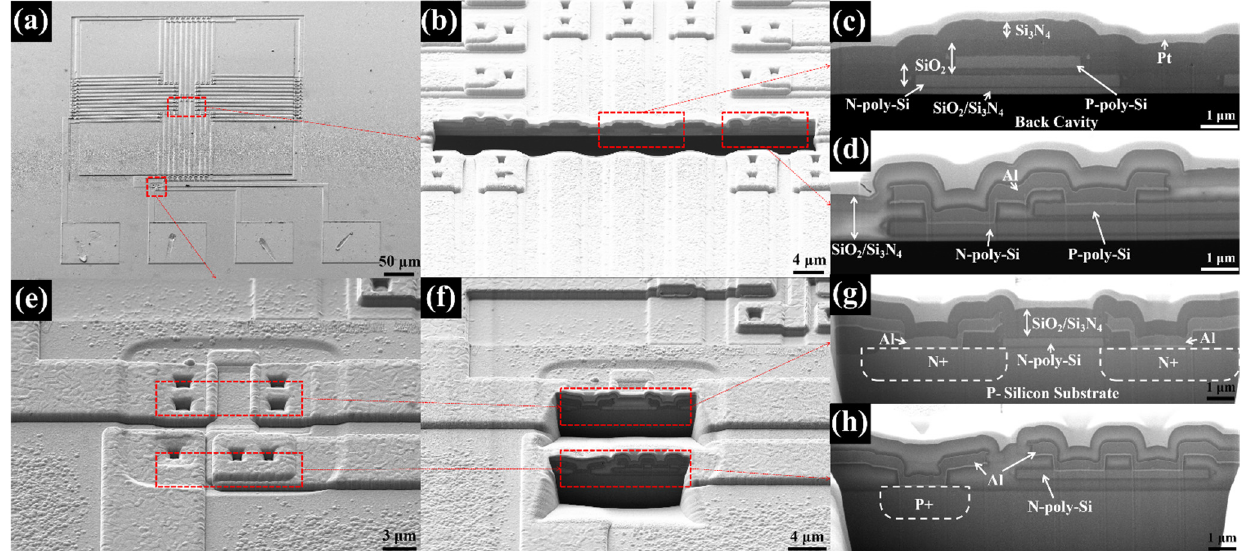
Figure 5. SEM images of ( a ) A TISA pixel, ( b ) A sectional position of a thermopile, ( c ) An enlarged image of a thermocouple, ( d ) An enlarged image of the hot junction, ( e ) An enlarged image of the NMOS, ( f ) Sectional positions of the NMOS, ( g ) An enlarged image of drain-gate-source structure, ( h ) An enlarged image of bulk contact and gate contact.